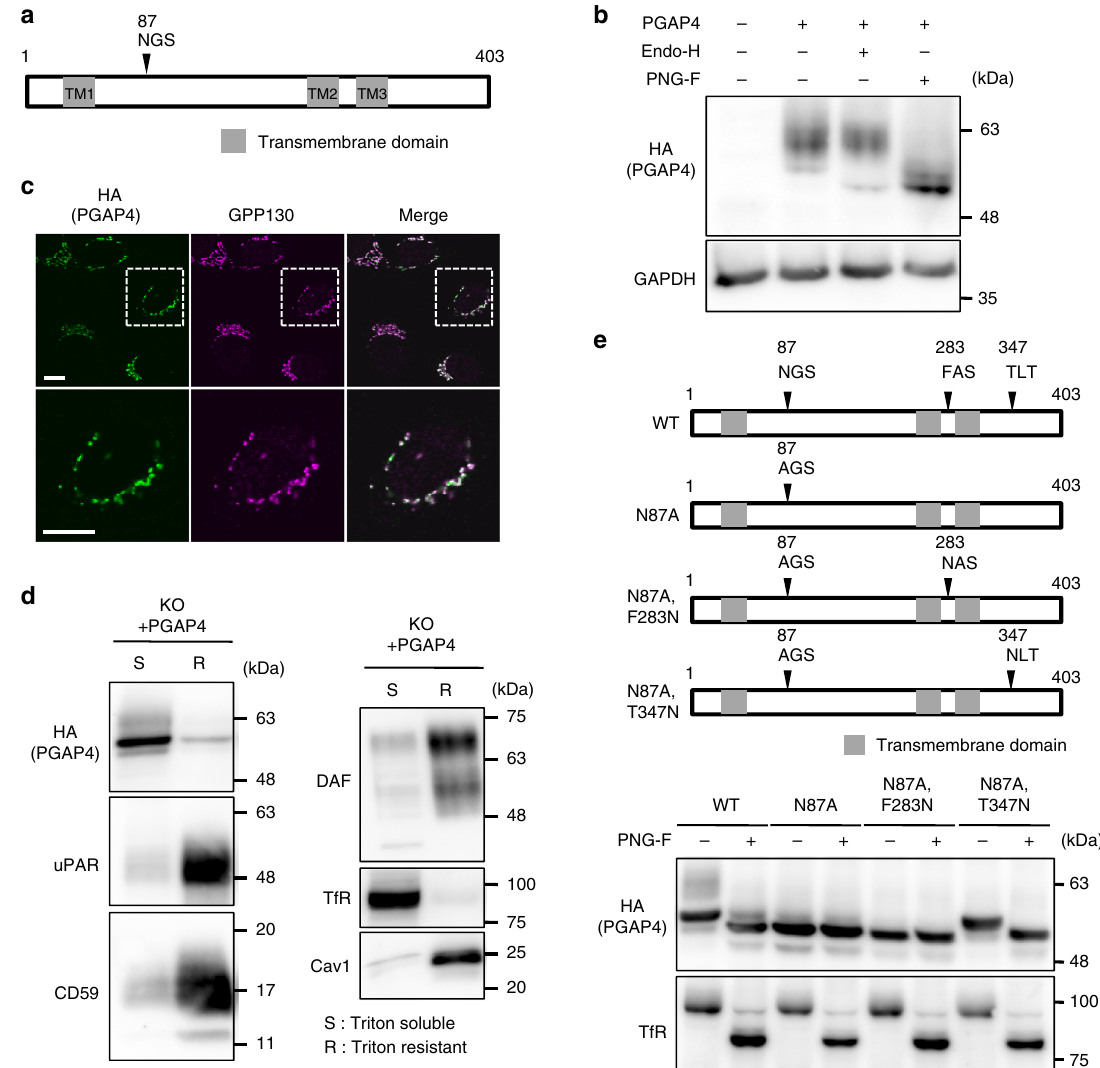
Fig. 3 Characterization of PGAP4. a Schematic of PGAP4 protein. Arrowhead, an N -glycosylation site; gray boxes, transmembrane domains. b Western blotting of PGAP4. Lysates of 3B2A cells stably expressing PGAP4-3HA were treated with Endo H or PNGase F followed by western blotting. GAPDH, a loading control. c Immuno fl uorescence imaging of PGAP4. 3B2A was transiently transfected with pME-hPGAP4-3HA. Lower panels are enlarged images of regions surrounded by white squares in the upper panels. GPP130, the Golgi marker. Scale bars: 10 µ m. d Non-DRM localization of PGAP4. Lysate of 3BT5- PGAP4-KO cells transiently expressing PGAP4-3HA were fractionated into Triton-soluble (S) and -resistant (R) fractions and subjected to western blotting. e Analysis of PGAP4 topology. (Upper) Schematic of PGAP4 WT and N -glycosylation mutants. Arrowheads, target sites of mutations. (Lower) Western blotting of PGAP4 WT and mutants. pME-hPGAP4-3HA was transiently transfected in 3B2A cells. Lysates were treated with or without PNGase F. TfR, a positive control for PNGase F treatment. b – e Representative data from two independent experiments. See also Supplementary Fig. 4 and